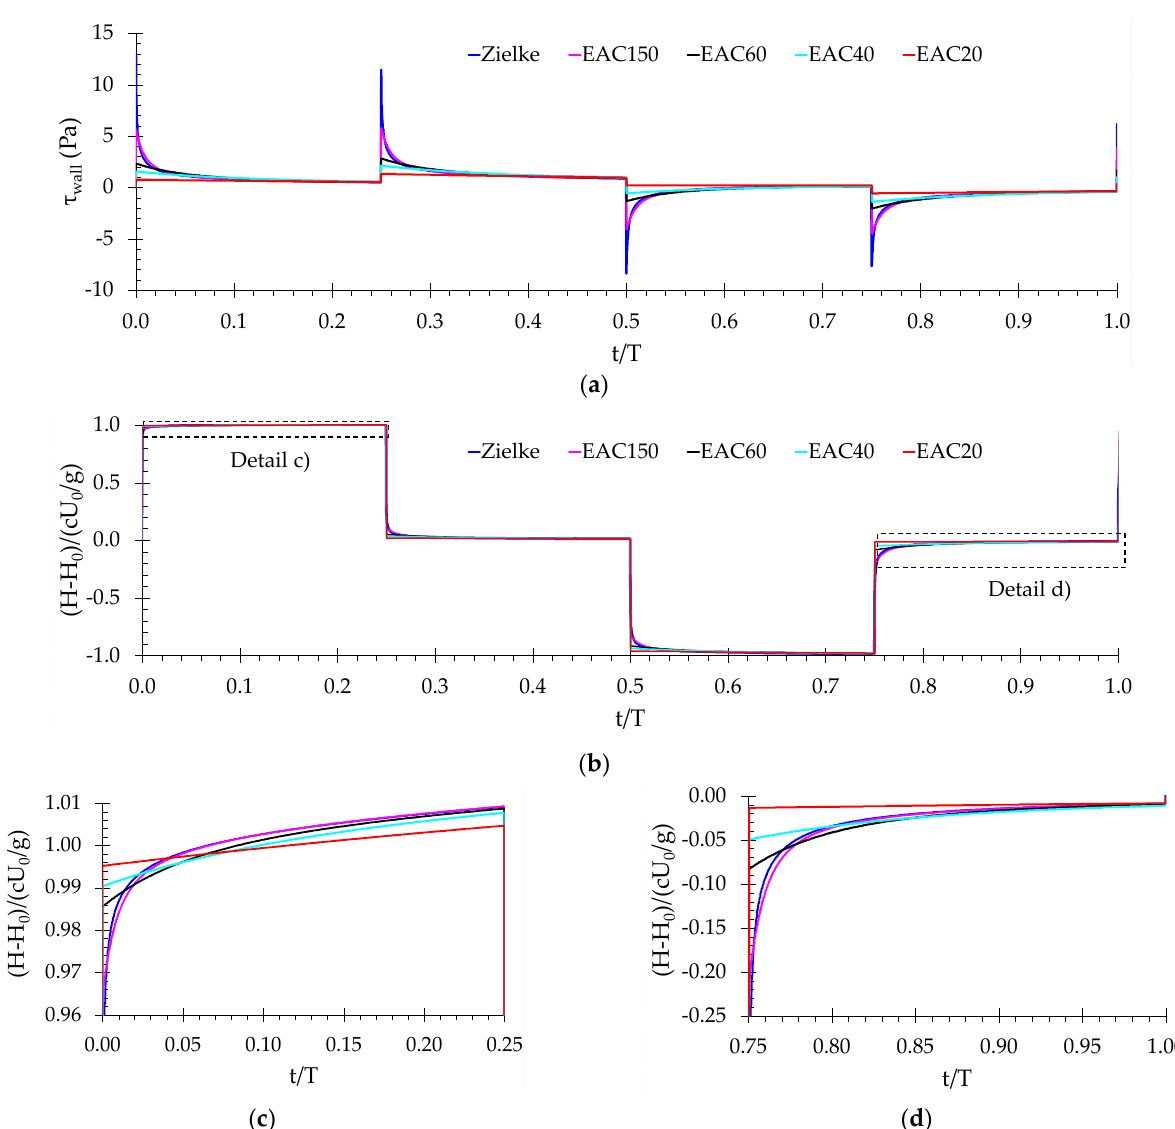
Figure 5. Q2D simulations for EAC meshes with increasing N C using Zielke’s 1D model as benchmark: ( a ) wall shear stress; ( b ) piezometric-head; ( c , d ) details of the piezometric-head. The pressure surge arrival shifts the steady-state axial velocity profile and an inflection point with a high axial velocity gradient appears near the pipe wall because of the no-slip condition. From t 0 to t 5 , the velocity profile gradient near the wall reduces as the inflection point moves into the pipe core. The transient flow changes occur close to the pipe wall. At t 4 , just before the next pressure surge, the inflection point maximum displacement from the pipe wall is less than 4% of the pipe radius. Therefore, a high percentage of the pipe